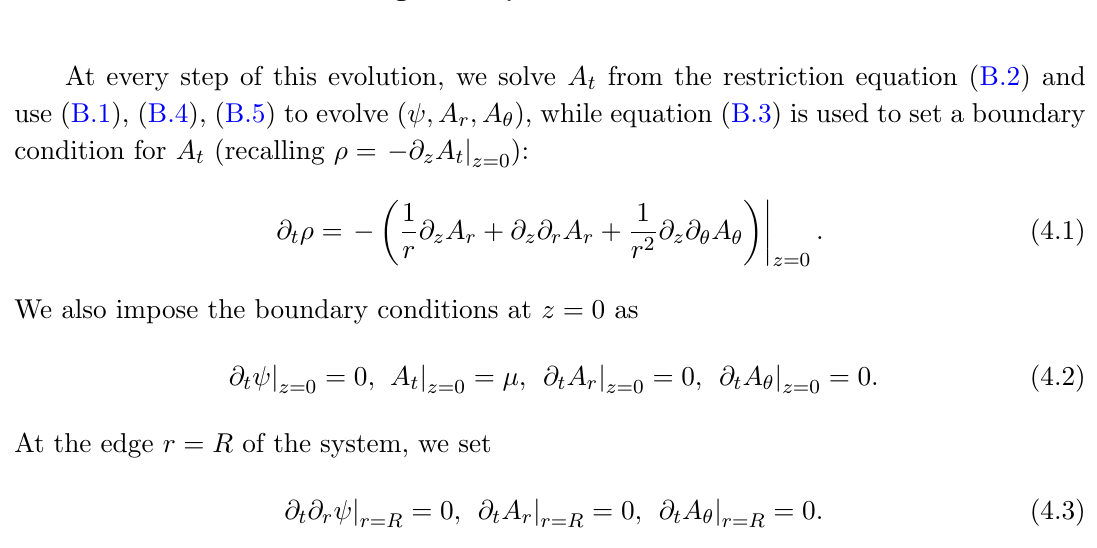
Figure 3. Quasi-Normal